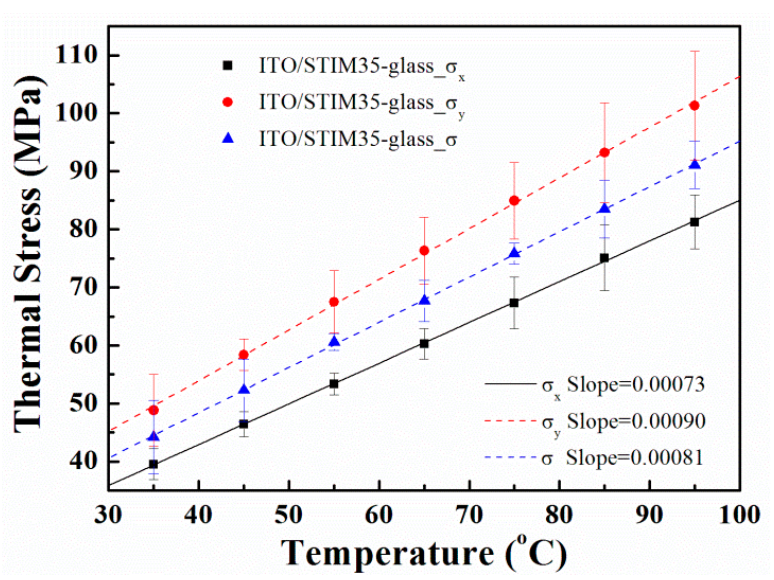
Figure 7. Thermal stress vs. temperature plot of ITO coated on the S-TIM35 substrate.